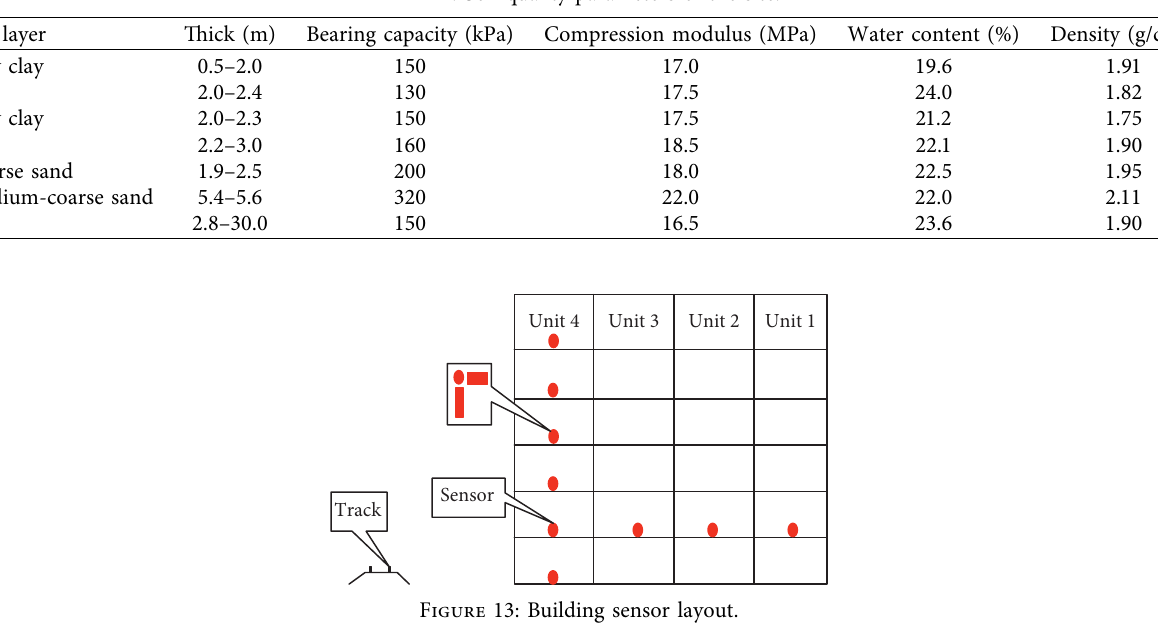
Figure 12: The schematic diagram on-site. Table 4: Soil quality parameters of the site.